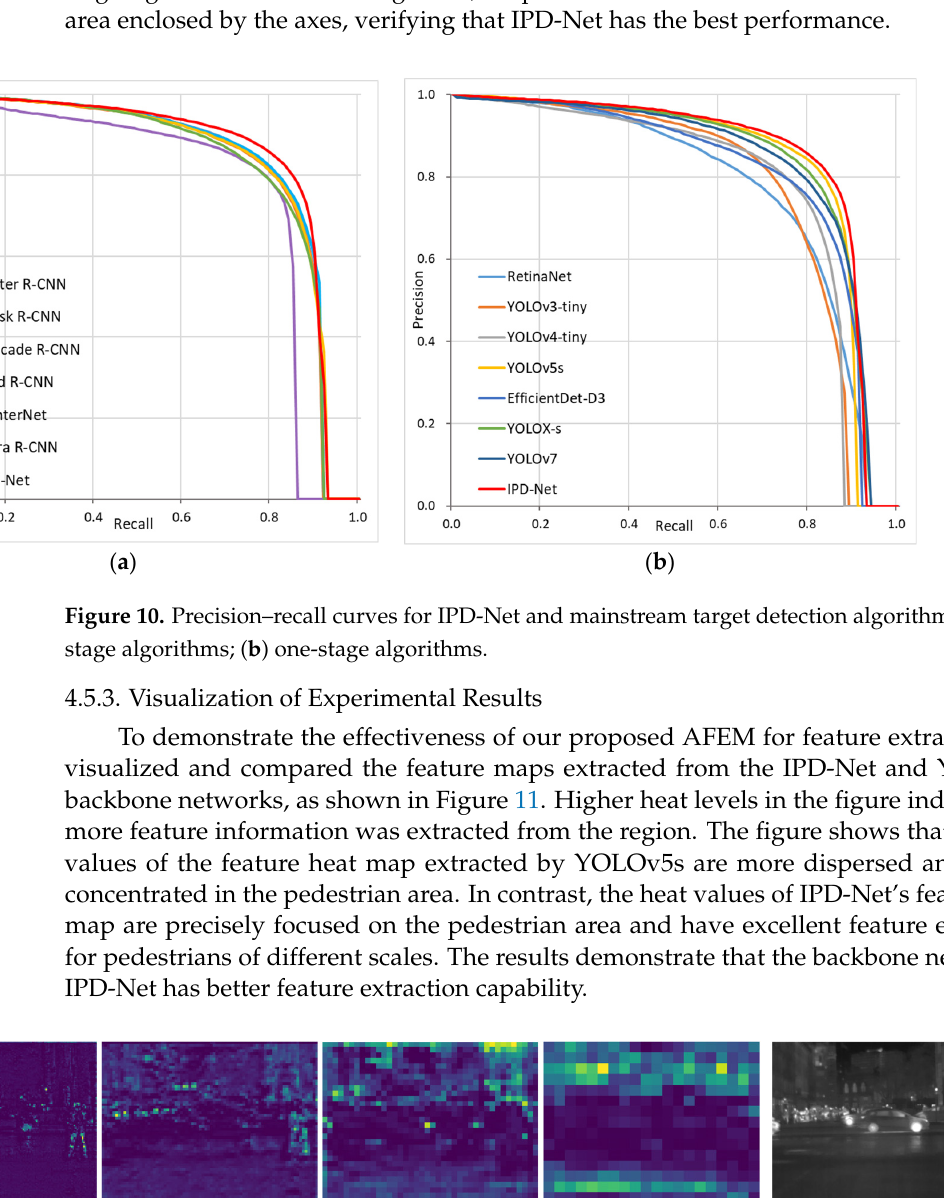
( c ) Figure 12. Infrared pedestrian detection instance, where the green boxes represent the pedestrians annotated in the dataset, the yellow boxes represent the detection results inferred by YOLOv5s, and the red boxes represent the detection results inferred by IPD-Net: ( a ) Infrared image with annota- tion; ( b ) YOLOv5s detection results; ( c ) IPD-Net detection results. 5. Conclusions This paper analyses the shortcomings of existing object detection algorithms in the field of infrared pedestrian detection. To solve the problem of pedestrian detection in